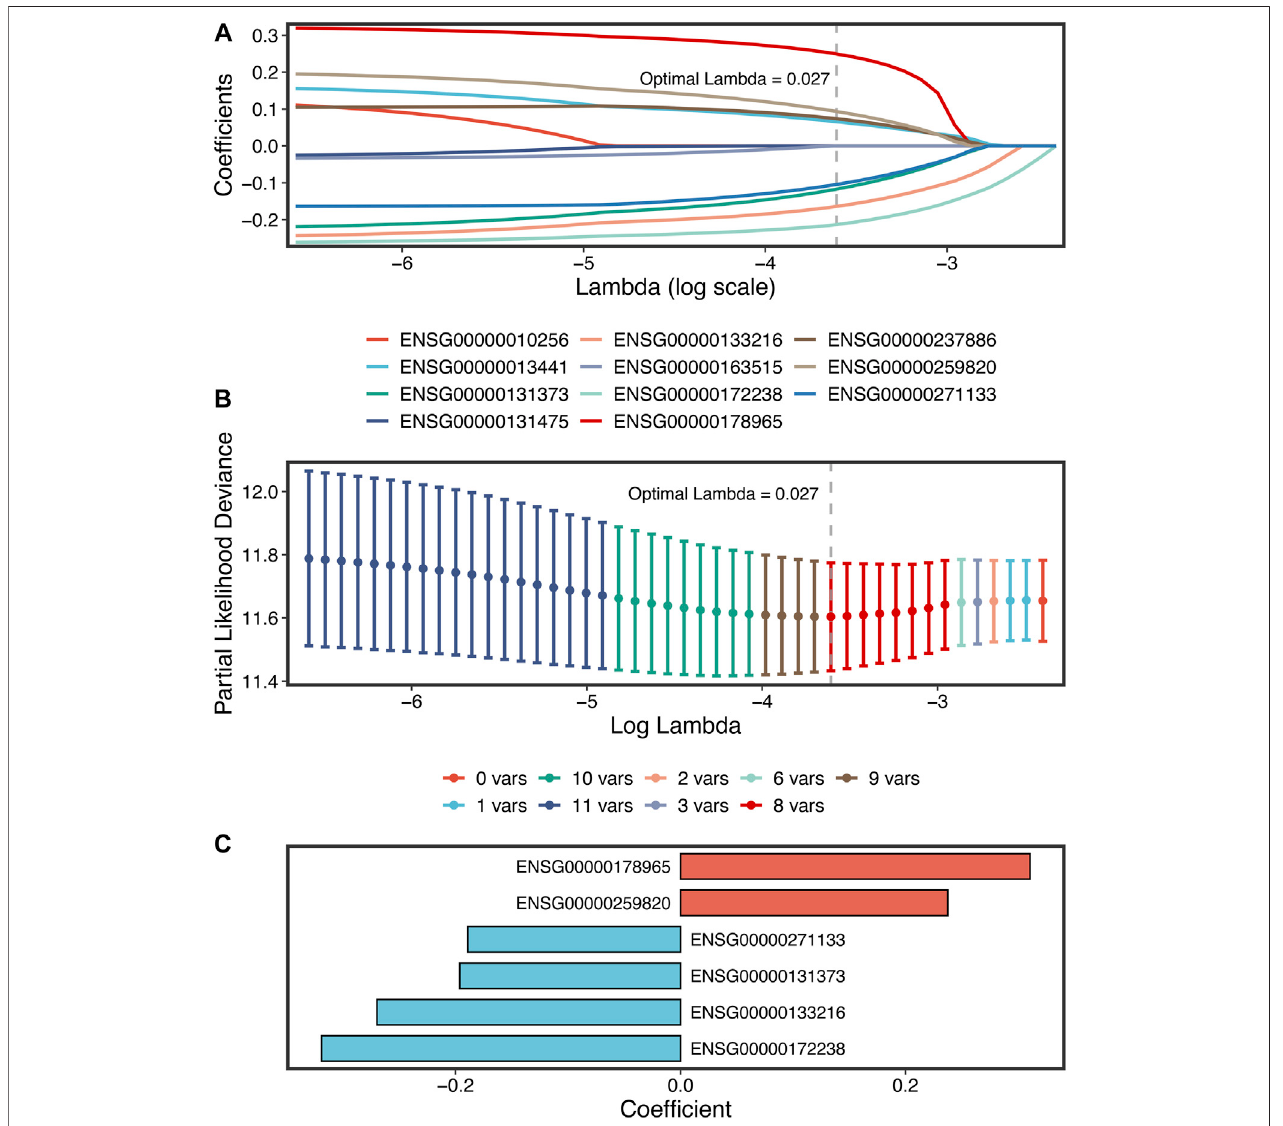
FIGURE 2 | The development of the MSSAS signature based on the LASSO stepwise Cox regression algorithms. (A) Ten-fold cross-validations to tune the parameter selection in the LASSO model. (B) LASSO coef fi cient pro fi les of the candidate genes for MSSAS construction. The vertical lines are drawn at the optimal values by minimum criteria. (C) Coef fi cients of six genes fi nally obtained in stepwise Cox regression.